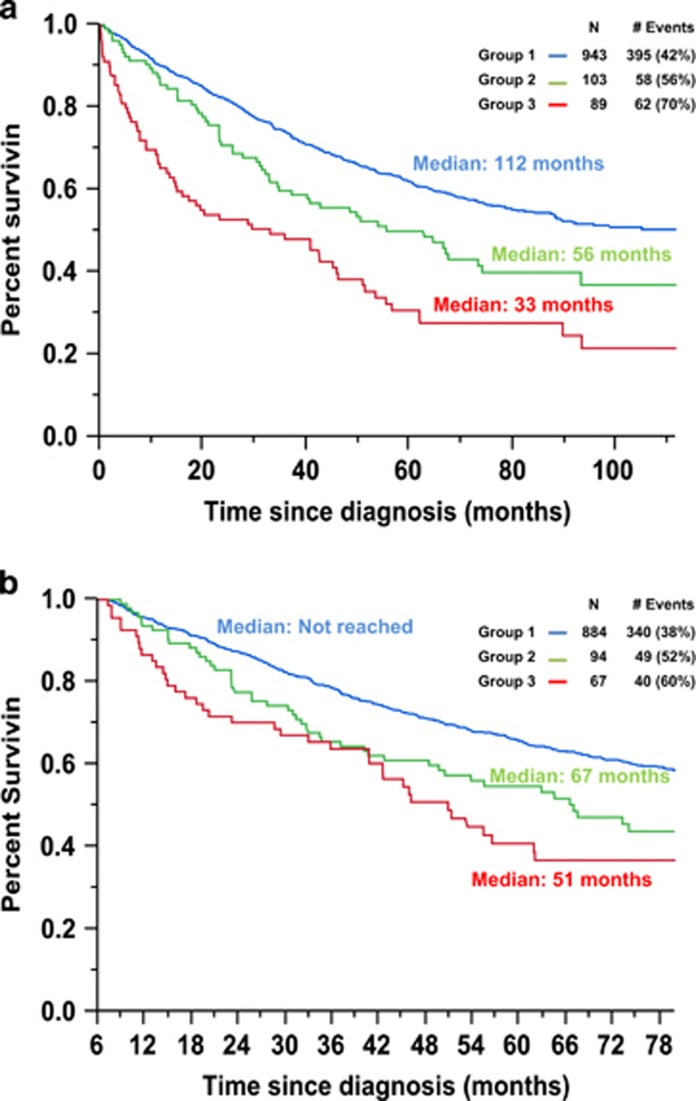
(a) Kaplan-Meier plot comparing overall survival between groups 1, 2, and 3 based on their renal function at diagnosis and response to therapy: group 1, CrCl⩾40 at diagnosis; group 2, CrCl<40 at diagnosis but improved to ⩾40 after therapy; and group 3, CrCl<40 at diagnosis and remained <40 after therapy. (b) Kaplan-Meier plot comparing overall survival at a 6-month landmark based on their renal function at diagnosis and response to therapy: group 1, CrCl⩾40 at diagnosis; group 2, CrCl<40 at diagnosis but improved to ⩾40 after therapy; and group 3, CrCl<40 at diagnosis and remained <40 after therapy.